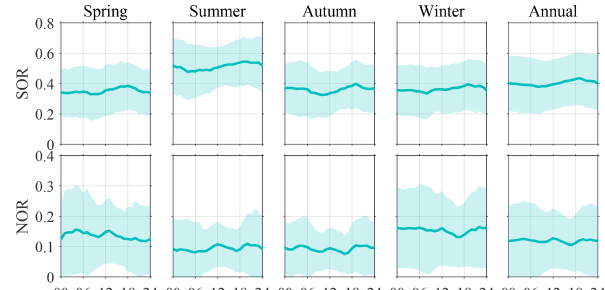
Figure 9. The same as Fig. 8 but for the SOR (upper panel) and NOR (lower panel) at SHT.